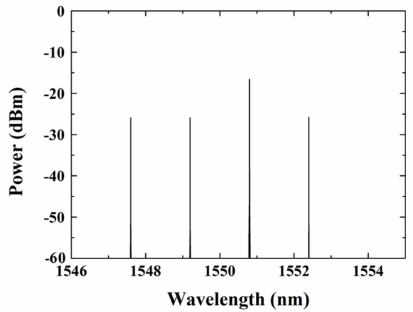
Figure 14. The spectrum at the output port 2 with the add λ 5 process (odd